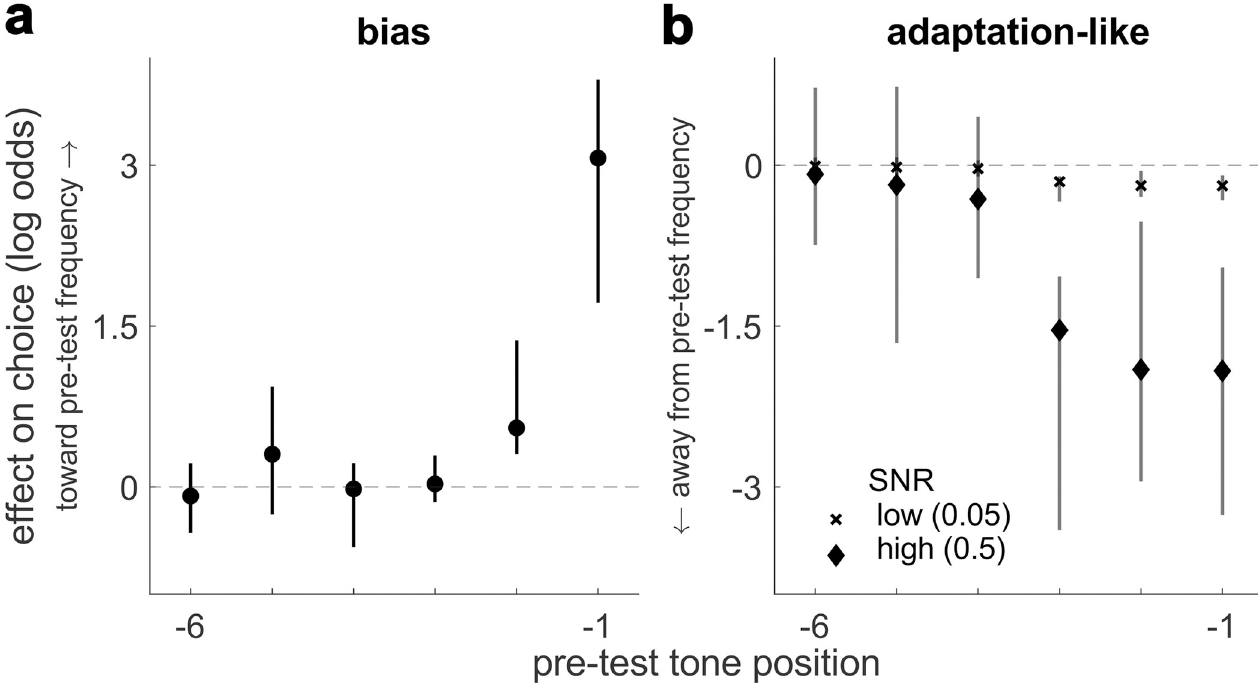
Fig 3. Logistic analysis of the bias ( A ) and adaptation-like ( B ) effects in the stimulus-based condition, as a function of pre-test tone position ( − 1 = the tone just prior to the test tone, etc.). Values along the ordinate are the medians of per-subject beta coefficients from the logistic model (points), and the error bars are bootstrapped 95% confidence intervals (computed using 10,000 bootstraps). These beta coefficients represent the effects of a pre-test tone presented at that position on choice, measured as log-odds ratios biasing choices toward (positive values) or away from (negative values) the frequency of the pre-test tone at the given position. In B , the two symbols (see legend) correspond to effects measured for different SNR values of the test tone. Note that the total effect of a given pre-test tone is found by summing the bias and adaptation-like effects, for a given test-tone SNR.